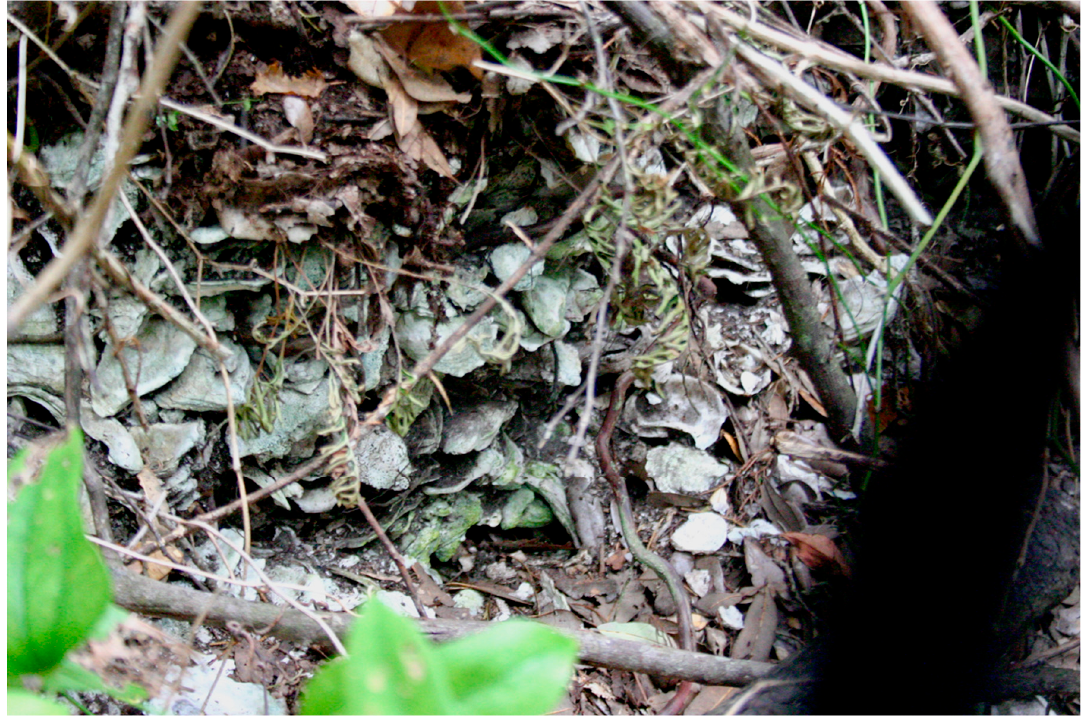
Figure 8. Stratigraphy of shell and dark organic soil peaking out from beside the walking path at Shell Mound. Photograph courtesy of the author.